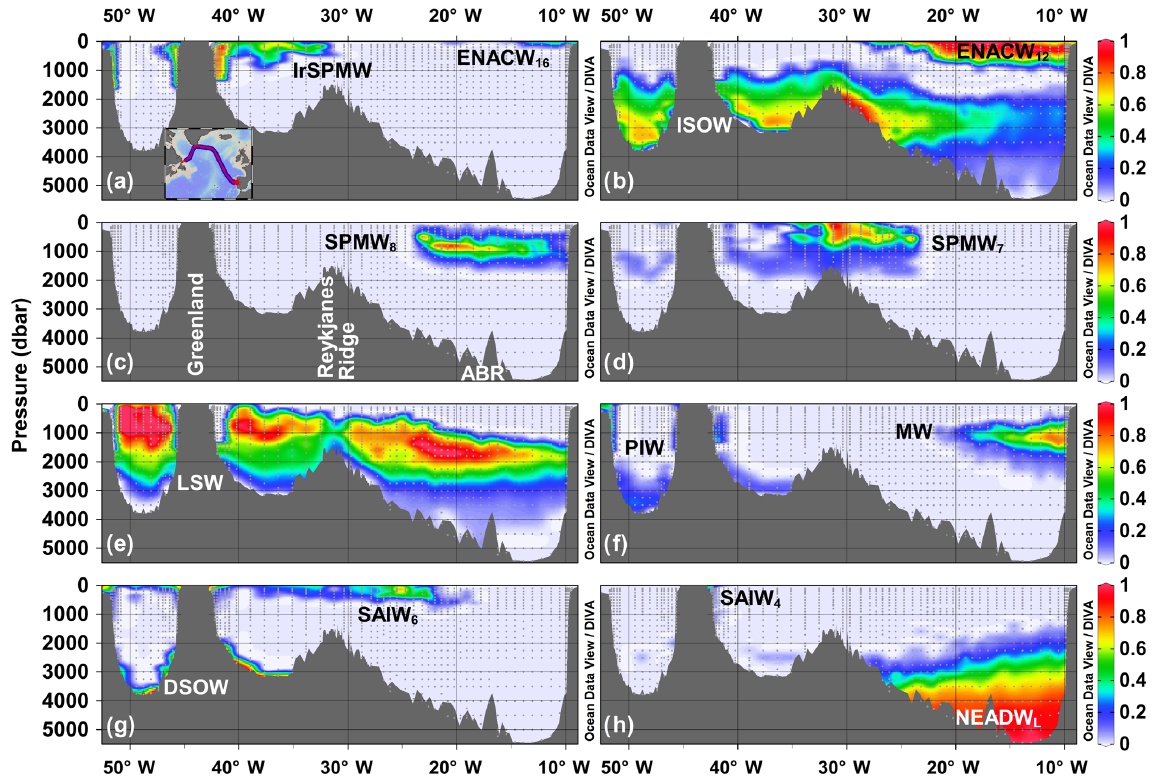
Figure 4. Water mass distribution resulting from the eOMP analysis for the 2014 GEOVIDE cruise (GEOTRACES-GA01 section, inset in subplot a ), from Portugal (right) to Canada (left). Sample locations appear as grey dots. ABR refers to Azores–Biscay Rise. Consult Table 1 for water mass